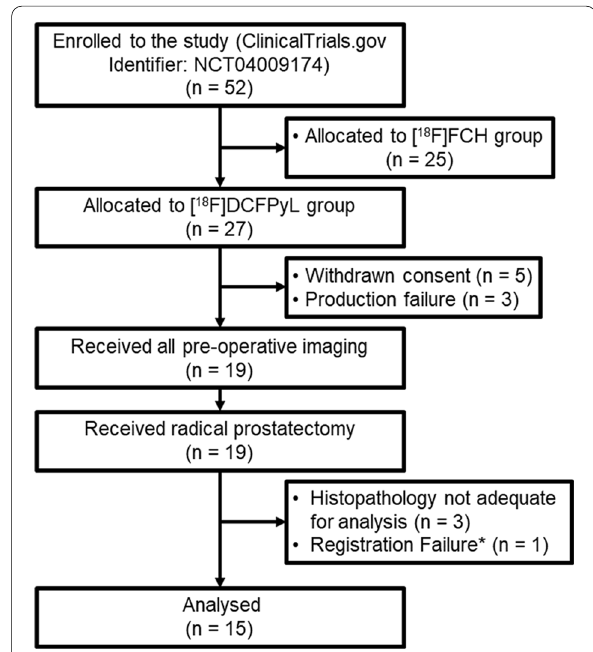
Fig. 2 Flow diagram showing patient enrolment. *Registration failed because the in vivo prostate was significantly deformed relative to explanted prostate due to gas in the rectum. FCH Fluorocholine, DCFPyL 2‑(3‑{1‑Carboxy‑5‑[(6‑[ 18 F]fluoro‑pyridine‑3‑carbonyl)‑amino] ‑pentyl}‑ureido)‑pentanedioic acid